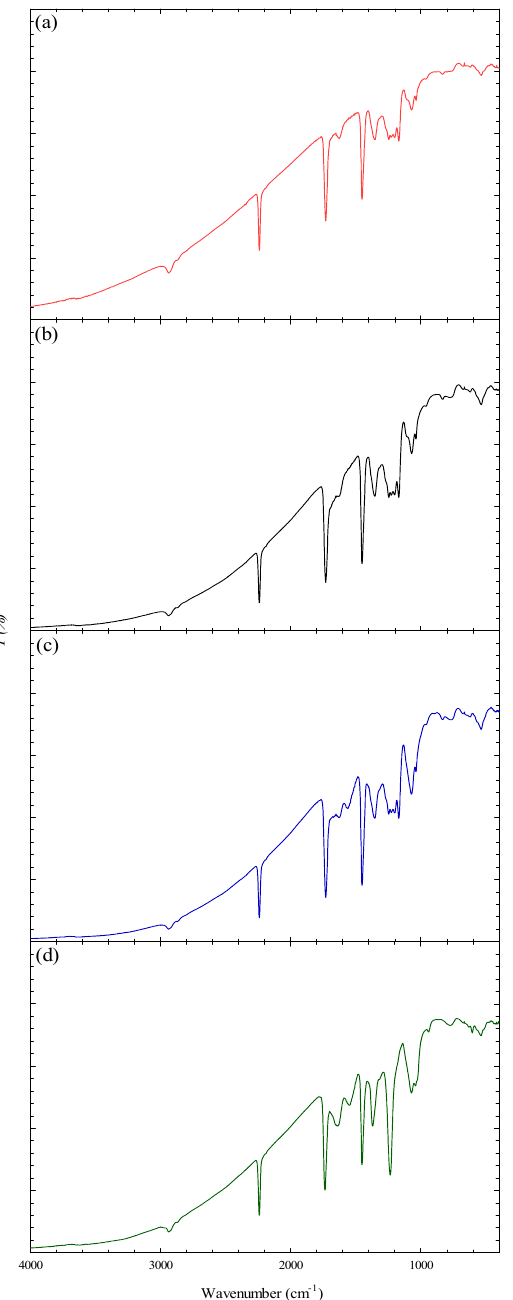
Figure 2. FTIR spectra of ( a ) PAN, ( b ) P-COOH, ( c ) P-COOH-CS, ( d ) P-COOH-CS-CEW. The shapes and structures of nanofiber membranes (PAN, P-COOH, P-COOH-CS, and P-COOH-CS-CEW) are shown in the SEM images (Figure 3). For all the fabricated nanofiber membranes, the nanofibers were randomly oriented and in the size range of 400–600 nm. The P-COOH film contained a rough structure. After the surface modifica- tion of P-COOH with chitosan and CEW, the thickness of nanofibers of P-COOH-CS-CEW increased marginally. Nevertheless, no obvious change in the overall nanofiber shape was